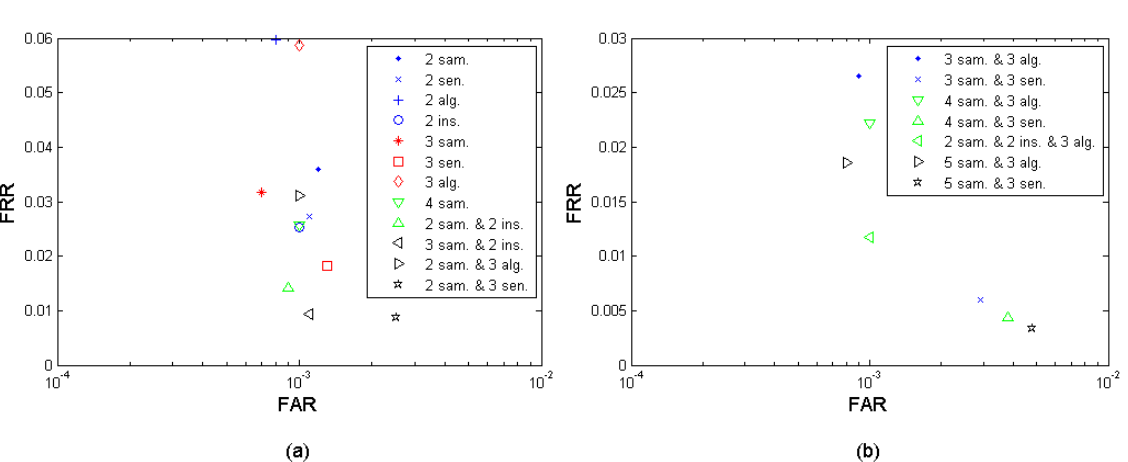
Figure 13. Fusion efficiency by “efficiency per decision”. (“sample”, “algorithm”, “sensor”, and “instance” are abbreviated as “sam.”, “alg.”, “sen.”, and “ins.”, respectively).